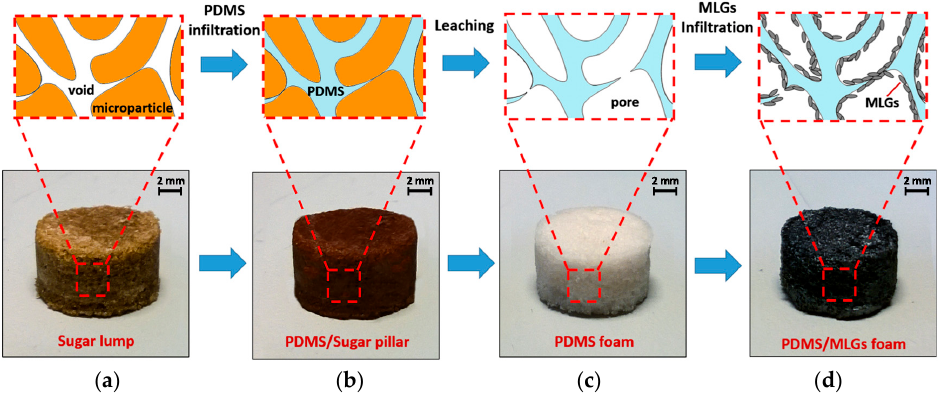
Figure 3. Products at the end of the distinct production steps: ( a ) sugar lump extracted from molds; ( b ) sample after PDMS infiltration; ( c ) PDMS foam after leaching; ( d ) PDMS foam after MLGs infiltration.